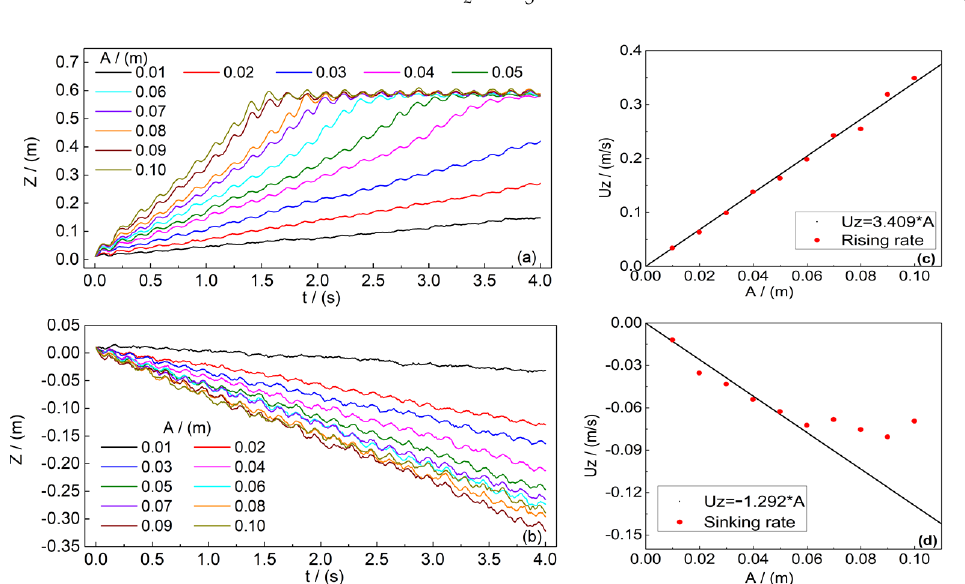
Figure 7. ( a ) The displacement of the SO in the z direction with amplitude A varying from 0.01 m to 0.1 m, for f = 3 Hz and Ω = − 80 rad/s; ( b ) the same for Ω = 80 rad/s; ( c ) the rising rate as a function of A for Ω < 0; ( d ) the sinking rate as a function of A for positive Ω >